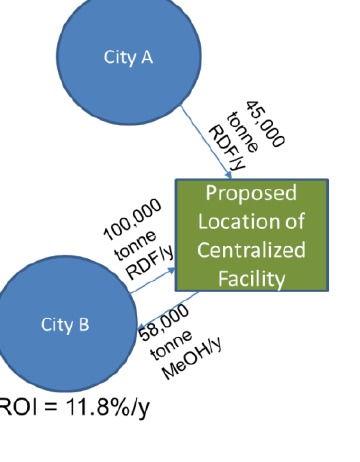
Figure 5. Economically optimum solution with a centralized facility (ROI is return on investment).